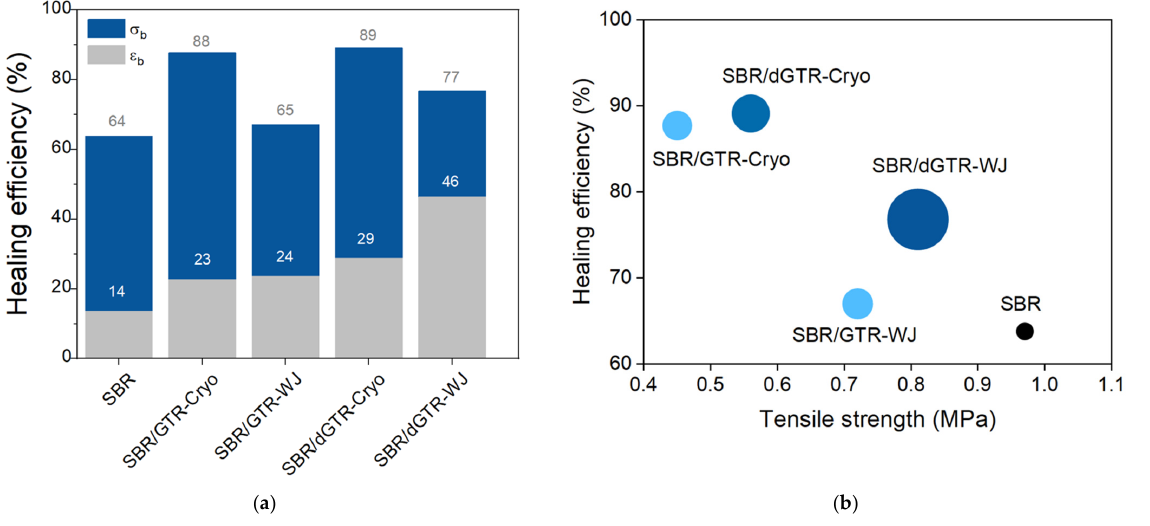
Figure 10. Influence of grinding protocols (cryogenic fracture, Cryo, and water jet, WJ) in the ( a ) healing efficiency and ( b ) tensile strength of SBR/30 phr dGTR compounds. The symbol size is scaled according to the recovery of the elongation at break. Adapted with permission from [85]. 2022.